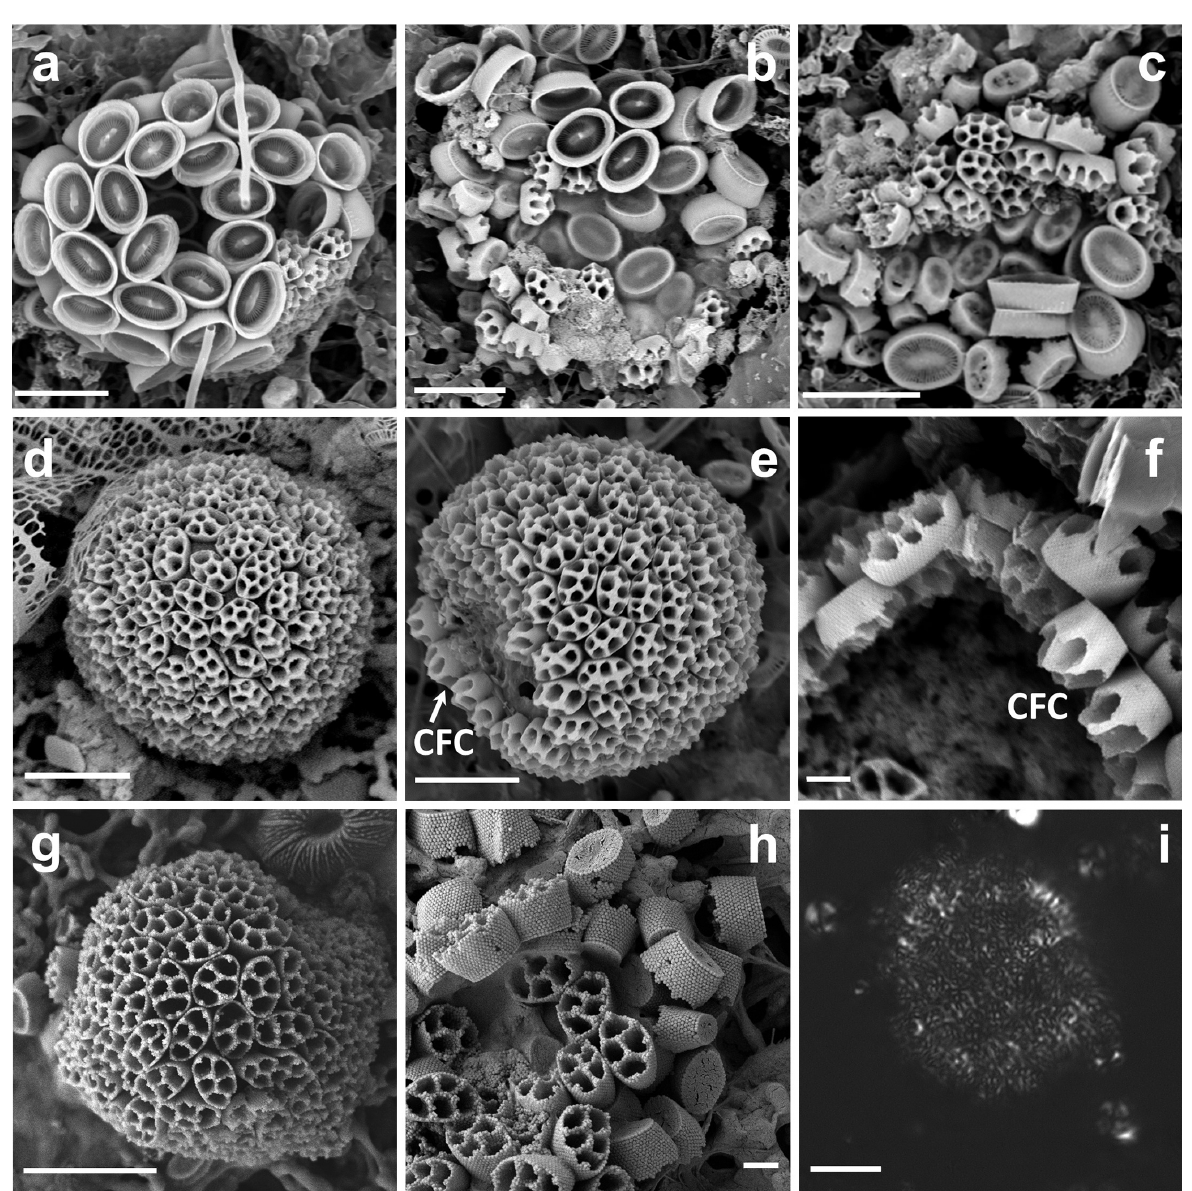
Figure 7. (a–c) Combination cells of Syracosphaera mediterranea with marisrubri -type HOL coccoliths (GoA, 29 October 2017, 40 and 60m). (d, e) HOL marisrubri -type coccospheres (GoA, 13 December 2018, 100m, and 7 January 2021, 2m). (f) Coccoliths with 5–10 perforations showing irregular walls and a domal shape. Coccoliths at apical pole (circum-flagellar coccoliths) have higher walls (GoA, 18 March 2018, 29m). (g) Coccosphere and (h) coccoliths of C. leptoporus HOL with four to six perforations and a higher and evenly high tube wall (GoA, 17 August 2017, 40m). (i) Polarized light microscopy image of S. mediterranea HOL marisrubri (GoA, 16 December 2020, 2m). Scale bars: 5µm, (f, h)